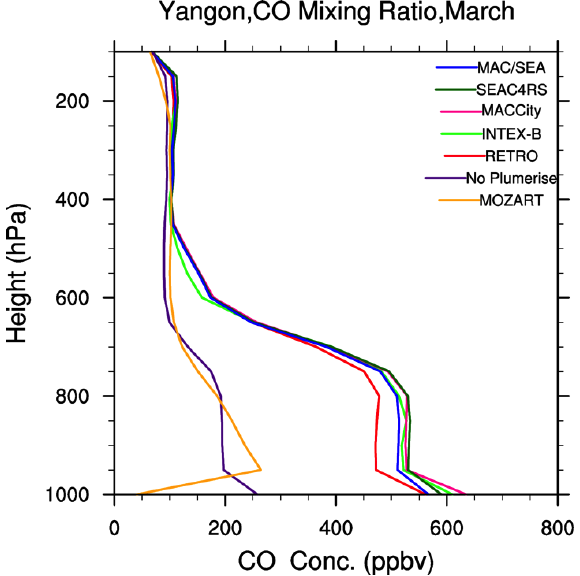
Figure 16. March monthly averaged CO vertical profiles at Yangon, Burma. WRF-Chem results with the plumerise feature of biomass- burning emissions are given for the MACCity–SEAC4RS emissions case (blue line), SEAC4RS emissions (dark green line), MACCity emissions (red line), INTEX-B emissions (green line), and RETRO emissions (dark red line). The MOZART global model results are shown as the gold line. WRF-Chem results without the plumerise feature (i.e., biomass-burning emissions injected into the lowest model level) are shown as the purple